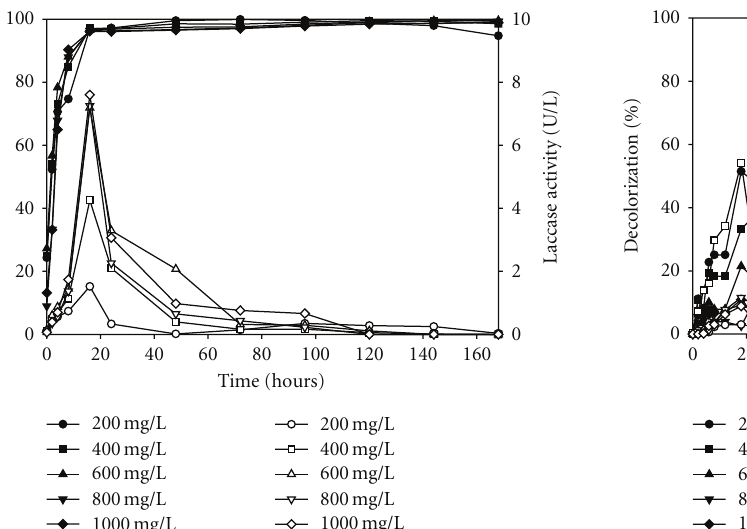
Figure 1: The e ff ect of reactive RBBR dye concentrations on %decolorization and Lac activity after cultivation with Datronia sp. KAPI0039; close symbol = %decolorization; open symbol = Laccase activity.